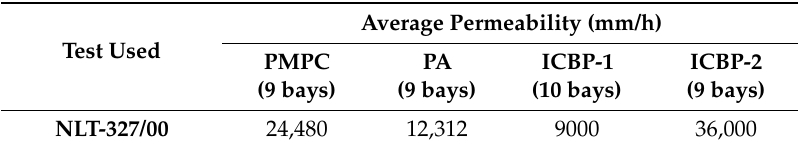
Table 2. Newly built permeability values for the porous-mixture surfaces.